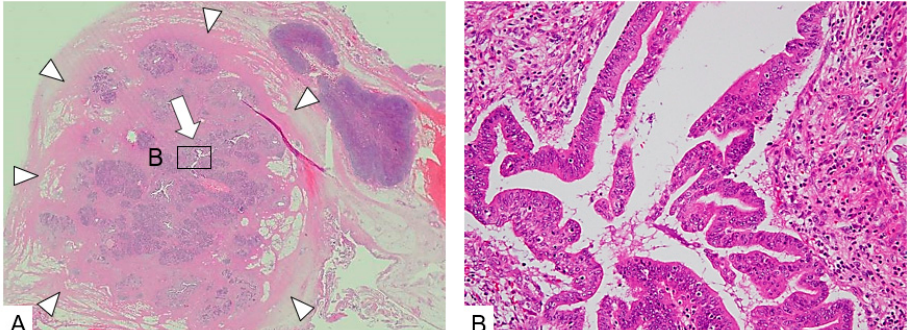
Figure 7. Tumor stricture type (2). ( A ) A large tumorous lesion with an irregular margin (arrow heads) is seen with a collapsed pancreatic duct (arrow) at the center of the lesion. The lesion consists of atrophied acinar with rich fibrous stroma. ( B ) The ductal epithelium changes to CIS surrounded by inflammatory cell infiltration and fibrous tissue. The diagnosis is so-called mass-forming pancreatitis with CIS. (H.E., ×100).